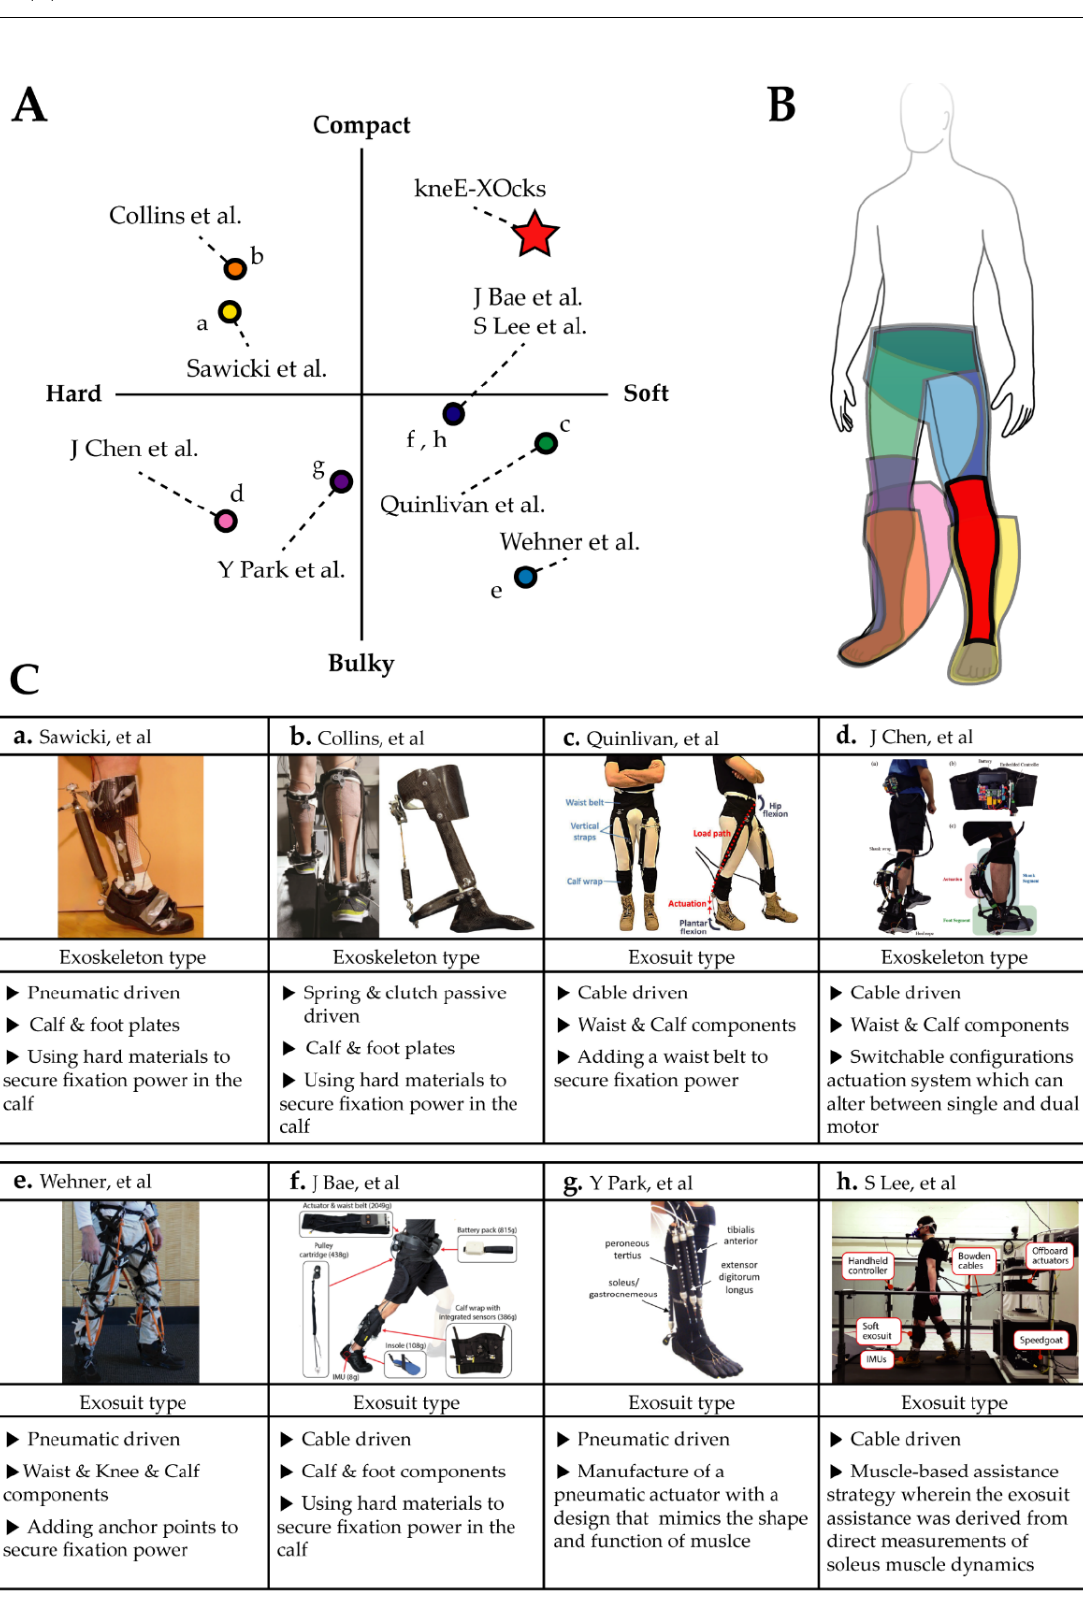
Figure 1. ( A ) Distribution chart of the degree of rigidity and volume of current wearable ankle robots. This image confirms the need for a new ankle robot that is soft and compact like kneE-XOcks. ( B ) Compact design of kneE-XOcks compared to existing wearable ankle robots. This can be confirmed through the illustration comparing the volume of kneE-XOcks and current wearable ankle robots. ( C ) Table analyzing and classifying the characteristics of current wearable ankle robots. Compared to existing wearable ankle robots, kneE-XOcks show a high auxiliary effect; consequently, they require a hard plate or additional fixing point in many parts [3 – 5,8,13 – 17].